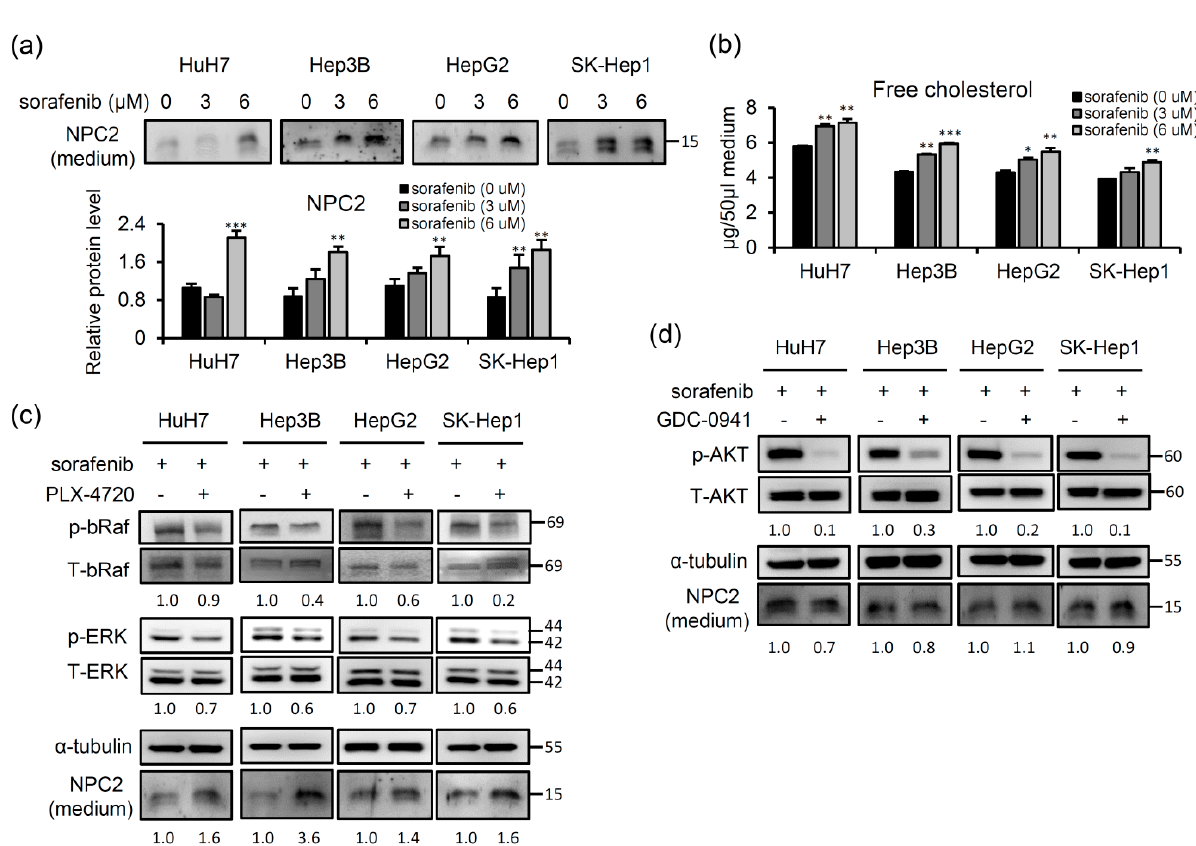
Figure 5. Sorafenib inhibition of the Raf signaling pathway increases the secretion of Niemann-Pick type C2 (NPC2) and free cholesterol into the cell culture supernatant. ( a , b ) NPC2 and free cholesterol levels in the cell culture supernatant of hepatocellular carcinoma (HCC) cells treated with the 0, 3, and 6 µ M sorafenib for 48 h. * p < 0.05, ** p < 0.01, *** p < 0.001 compared to black bars. ( c , d ) HCC cells were treated with 5 μ M of sorafenib and 1 μ M of a bRaf inhibitor (PLX-4720) or a phosphatidylinositol 3-kinase (PI3K) inhibitor (GDC-0941) for 24 h. Protein expressions of total (T)/phosphorylated (p)-bRaf, T/p-ERK, and T/p-AKT in cells and NPC2 in cultured media were analyzed by western blotting. ( c ) T-bRaf, T-ERK, and α -tubulin was used as a loading control. p-bRaf, p-ERK band, and NPC2 intensities of PLX-4720 ( − )/(+) pairs are shown under western blot images after normalization with control intensities. These experiments were repeated three times with similar results.